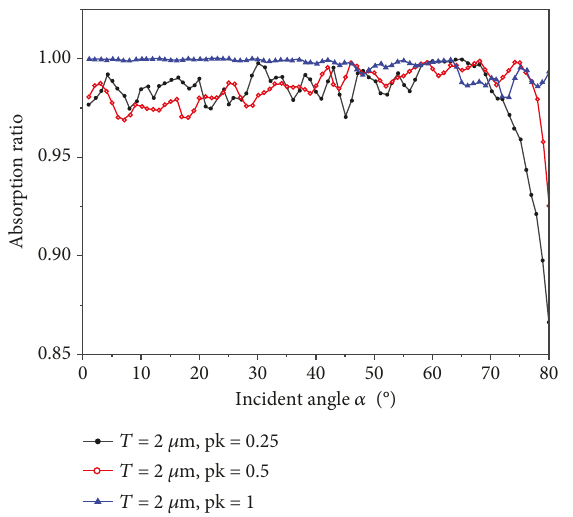
Figure 11: Absorptivity varying curve of random surface structure.